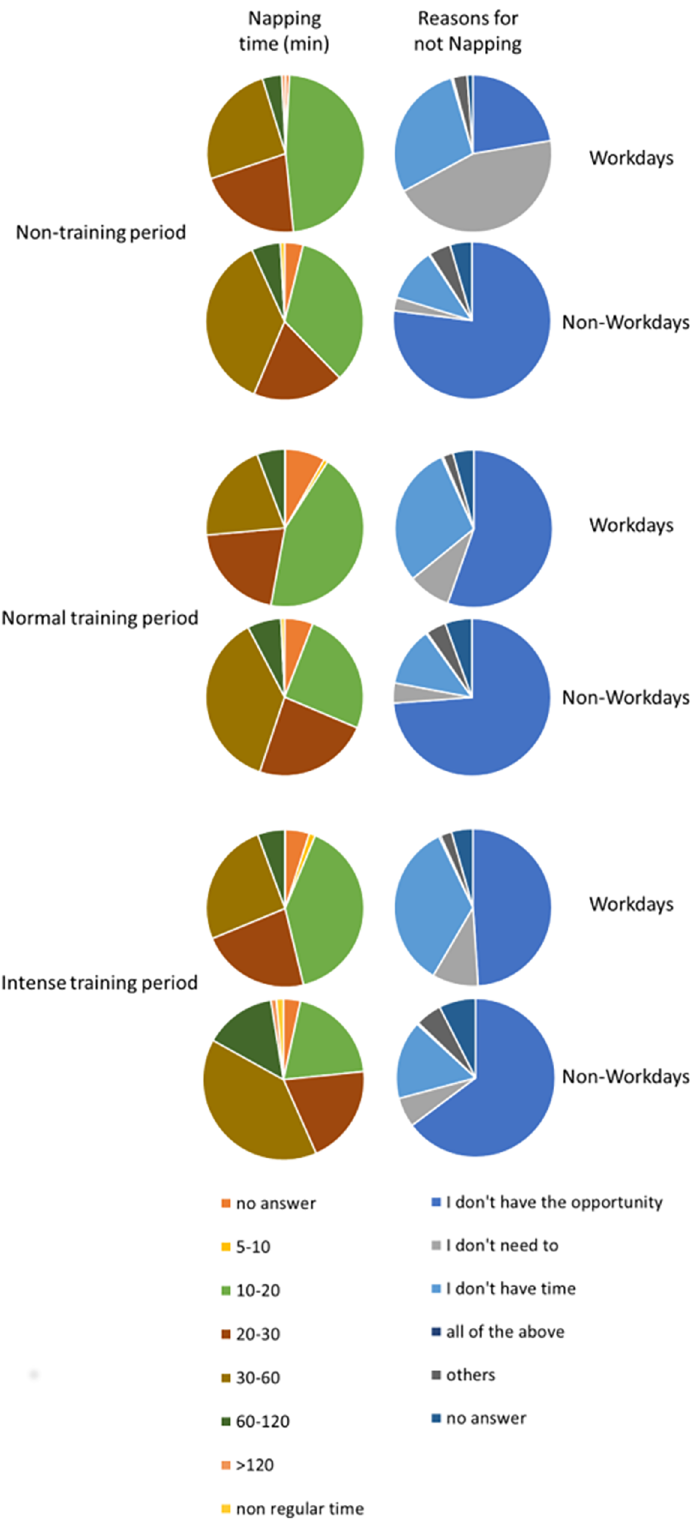
Fig 2. Distribution of napping durations and reasons for not napping during the different training periods and during workdays and non-workdays.